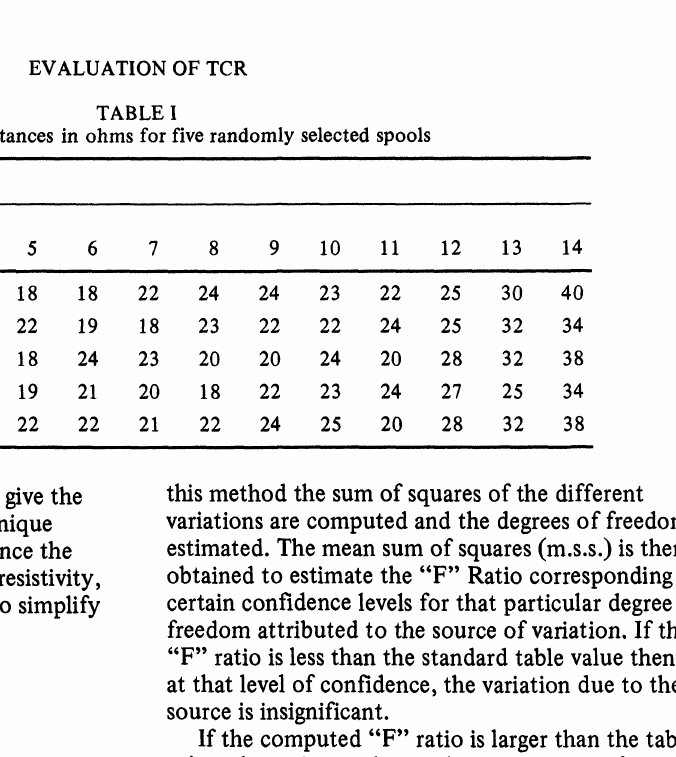
TABLE Substrate resistances in ohms for five randomly selected spools